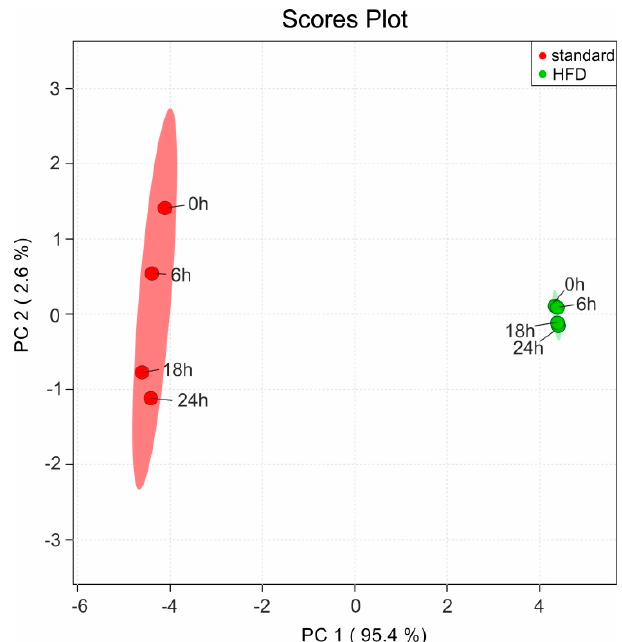
Figure 9. Statistical analysis of the variations in the NMR spectra over time using a PCA. The scores plot represents the explained variations in the samples for mice fed on standard diet (in red) and on HFD (in green) recorded at four different time points (0 h, 6 h, 18 h, and 24 h) with storage at RT.